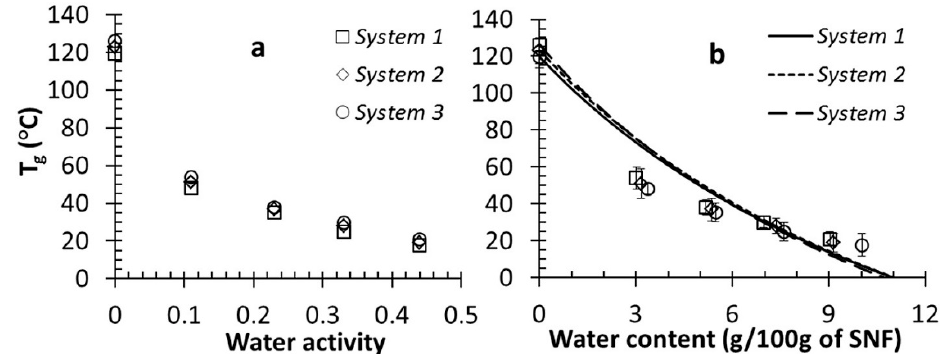
Figure 1. Effects of water activity ( a ) and water content (g/100 g of SNF) ( b ) on the onset (cid:1846) (cid:3034) in anhydrous and humidified trehalose-WPI-SO systems 1, 2, 3 (stages of emulsion) stored for 360 h at 25 ± 2 °C. Source: Maidannyk et al.